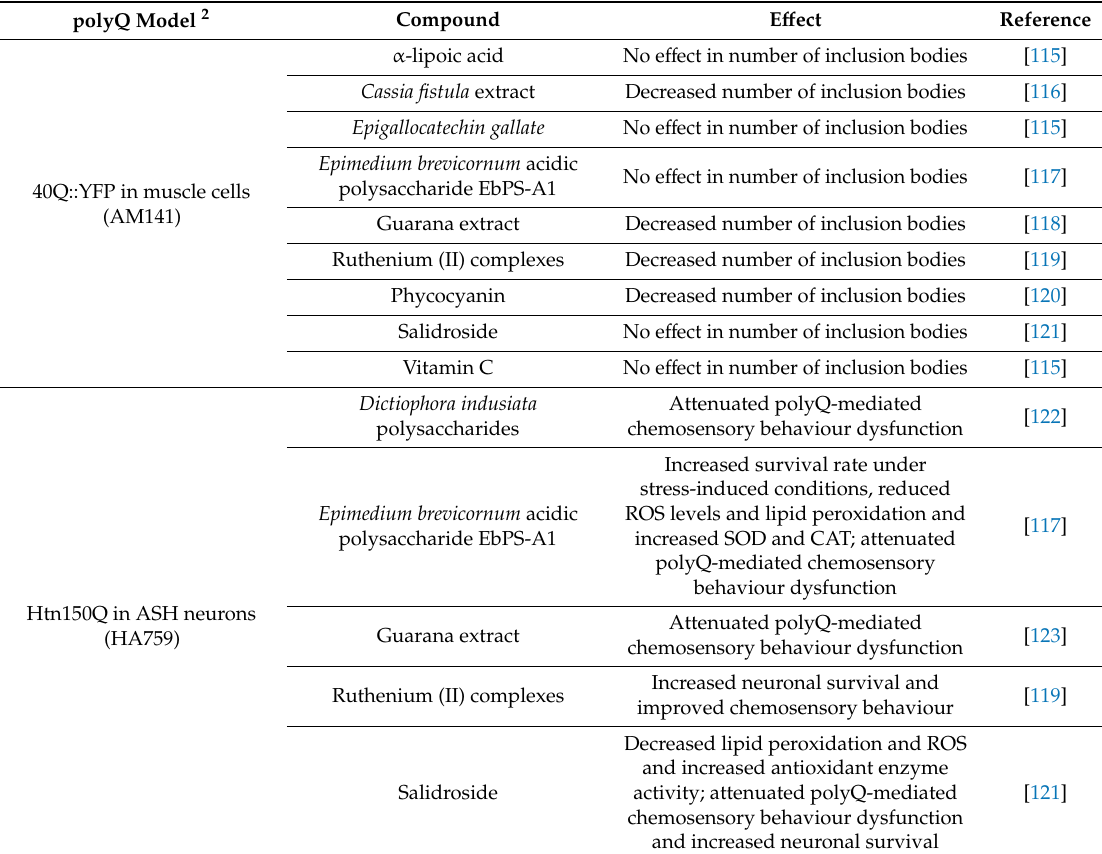
Table 1. Antioxidant therapies carried out in Caenorhabditis elegans 1